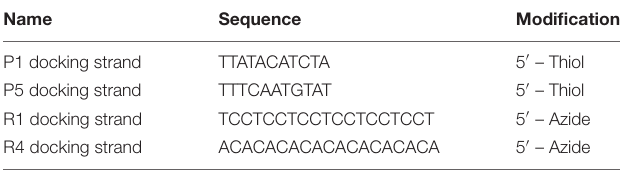
TABLE 1 | Sequences of docking strands.